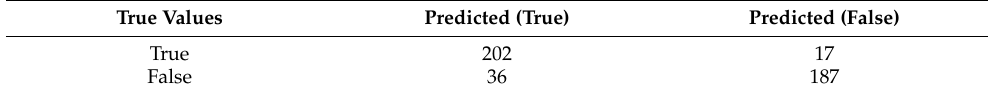
Table 11. GLM Confusion Matrix.